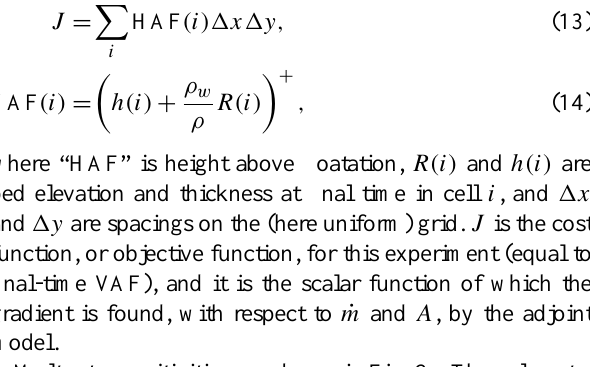
Fig. 2. (a) Sensitivity of grounded ice volume after 10 years to sub-shelf melt rates, in km 3 per (m/a) of melting. The non-colored section of the figure is within the grounded part of the domain (b) Similarly for Glen’s Law parameter A , but with units of 10 − 15 km 3 Pa − 3 a − 1 . A thick black contour denotes the grounding line. The largest values in both figures are in the ice shelf margins. Note the differing x - and y -bounds on the figures. Fig. 1. Background steady state of the ice stream-shelf system in Experiment 1. Coloring on the upper surface is velocity magnitude. The thick black contour denotes the grounding line. 47